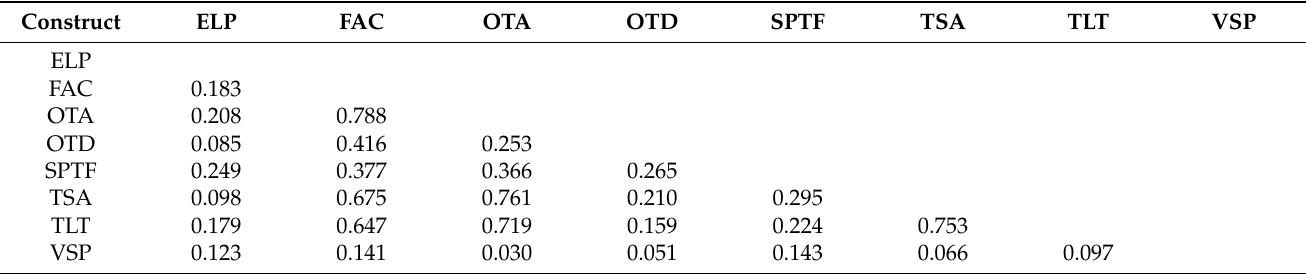
Table 3. Discriminant validity analyses (Heterotrait–Monotrait